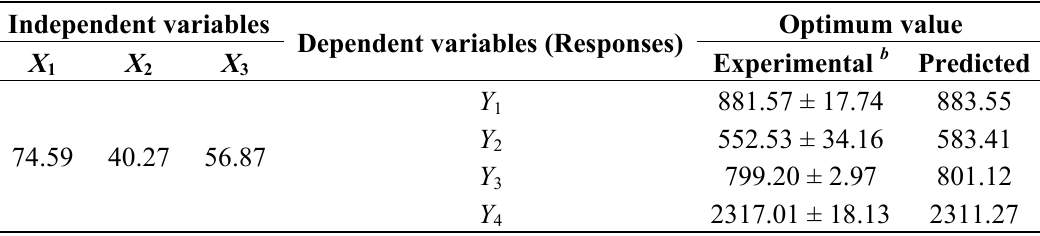
Table 4. Optimum conditions, predicted and experimental values of responses on extraction of Morinda citrifolia crude extract a